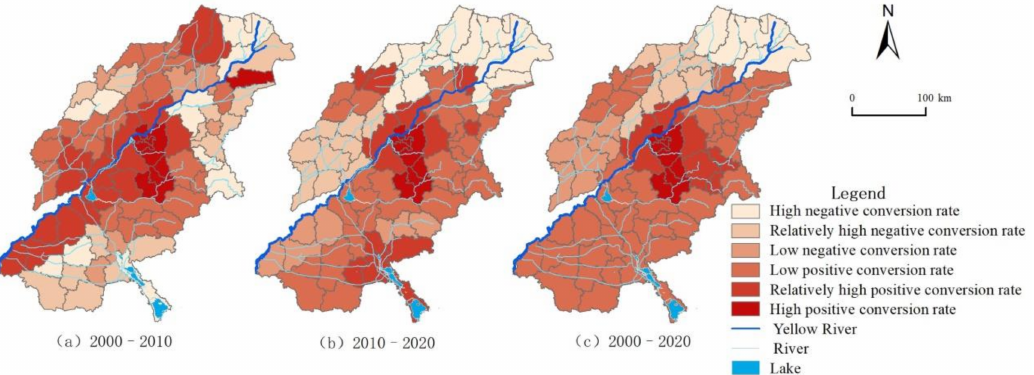
Figure 7. Spatiotemporal variation of LER grade in: ( a ) 2000, ( b ) 2010, and ( c ) 2020.